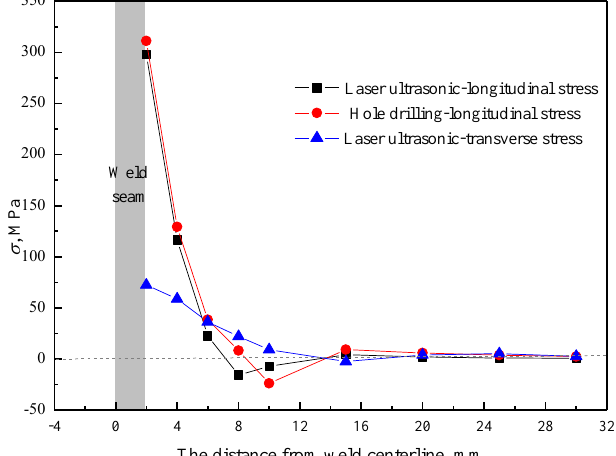
Figure 6. The residual stress distribution in TC4 laser welding at a welding power of 2800 W, welding speed of 6.0 m/min, and heat input of 28 kJ/m. The longitudinal residual stresses measured by the hole-drilling method and ultrasonic laser method were consistent.